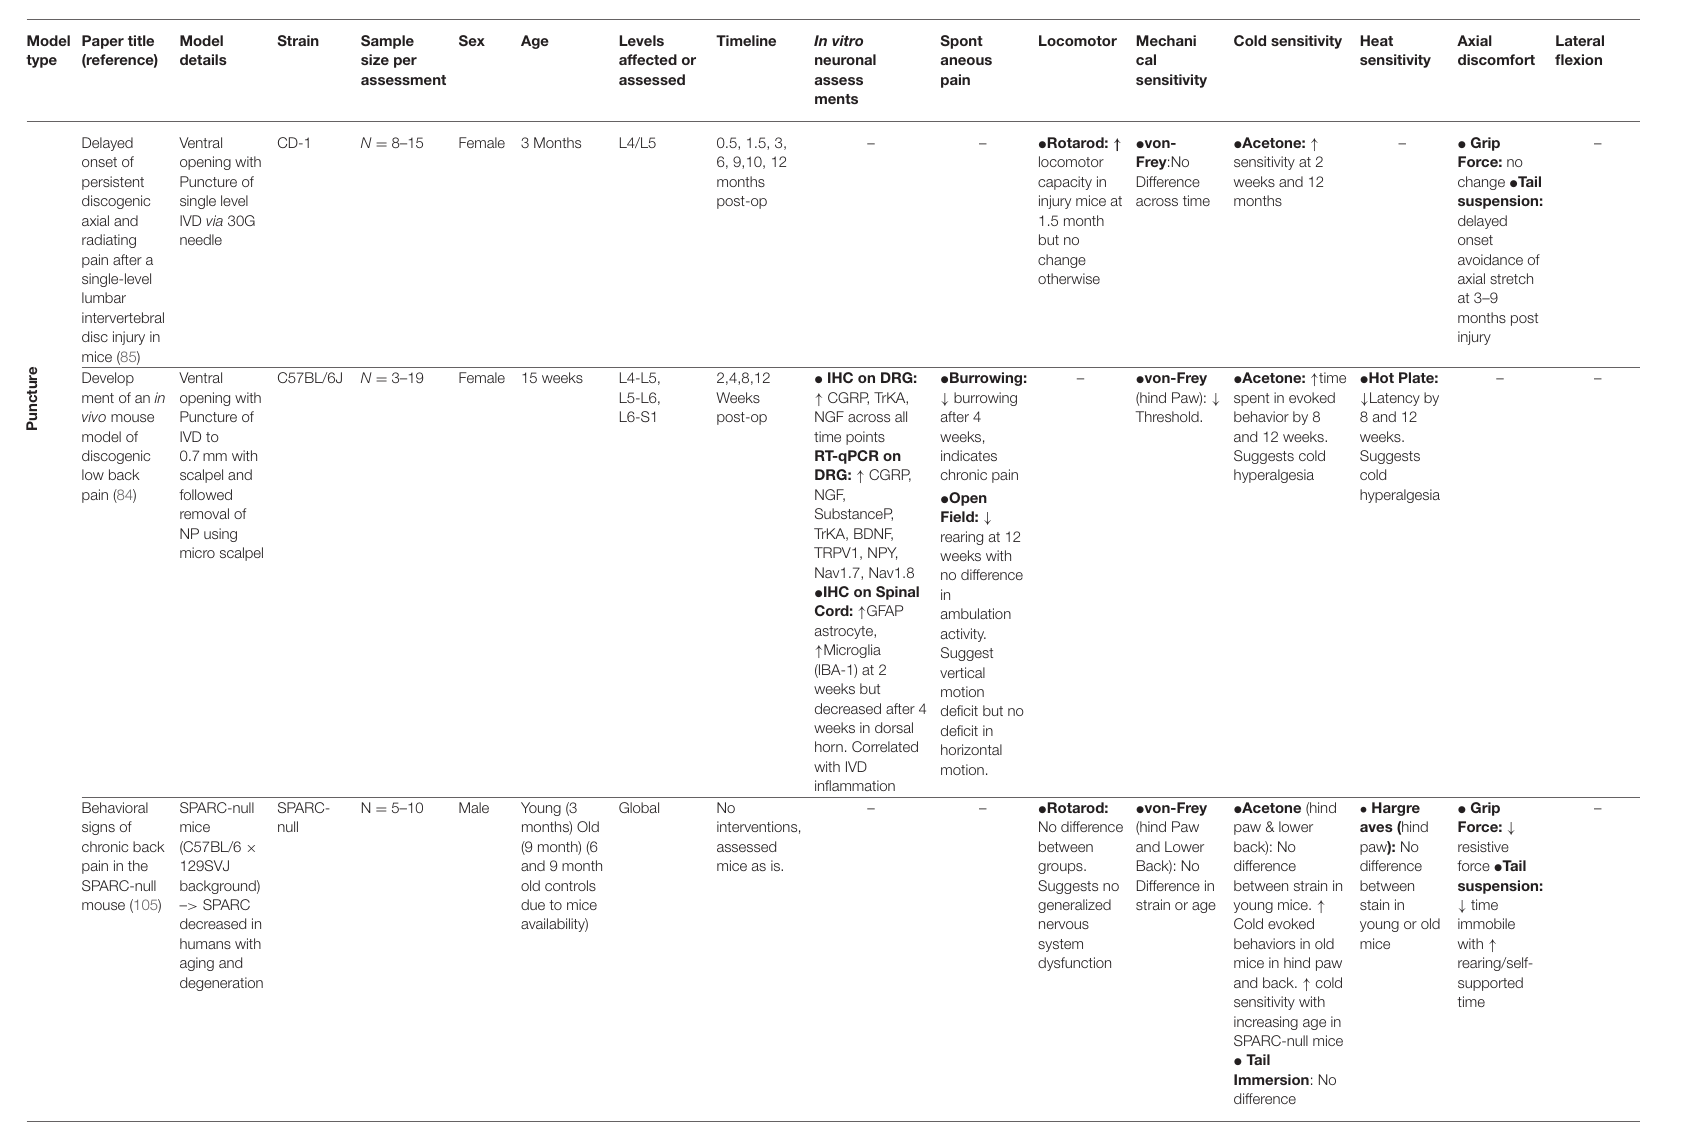
TABLE 3 | Comparison of mouse models and their pain behavioral